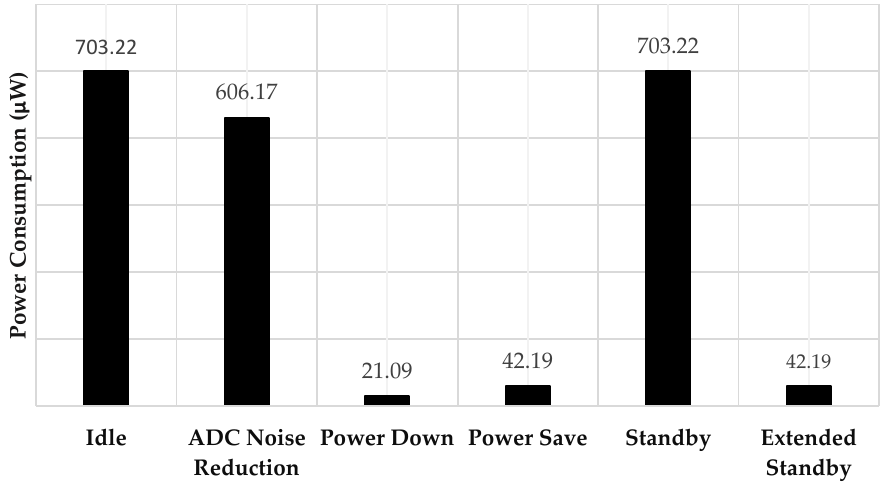
Figure 19. The measured power consumption comparison between different sleep modes of the ATMEGA328P MCU (at 3.7 v input).